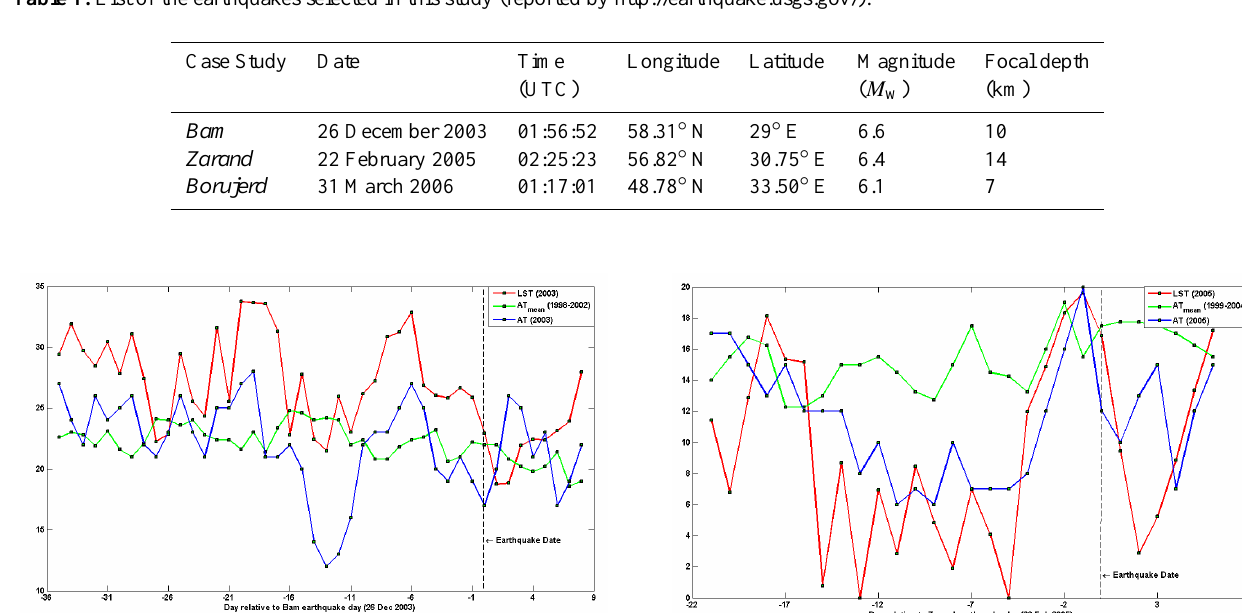
Table 1. List of the earthquakes selected in this study (reported by http://earthquake.usgs.gov/).